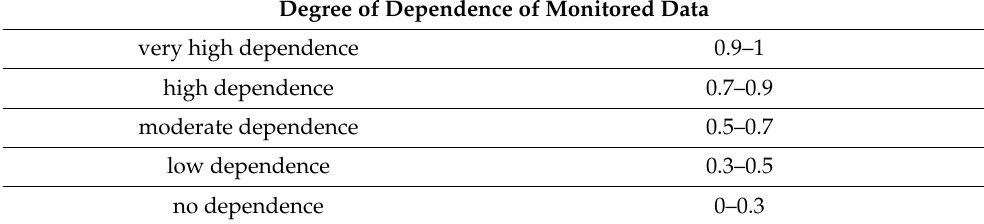
Table 7. Evaluation of correlation coefficients